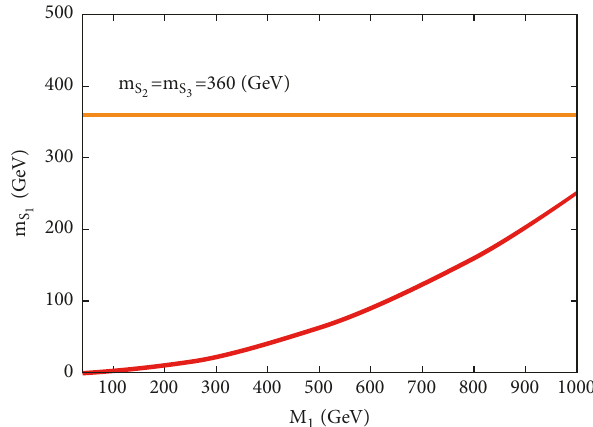
Figure 5: Prediction of singlet fermion mass eigen values as a function of 𝑁 − 𝑆 mixing mass parameters 𝑀 푖 (𝑖 = 1, 2, 3) for 𝑀 = 4 TeV (𝑖 = 1,2,3) . The horizontal red colored line represents 푁 𝑖 solutions for two other eigen values for 𝑀 2 = 𝑀 3 = 1200 GeV.